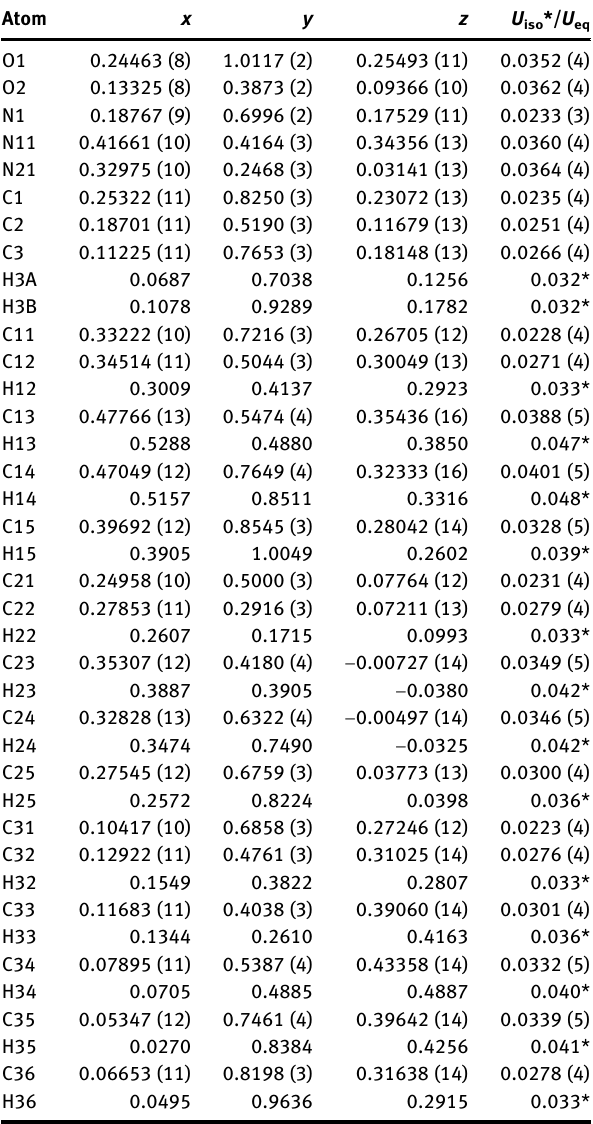
Table  : Fractional atomic coordinates and isotropic or equivalent isotropic displacement parameters (Å  ).